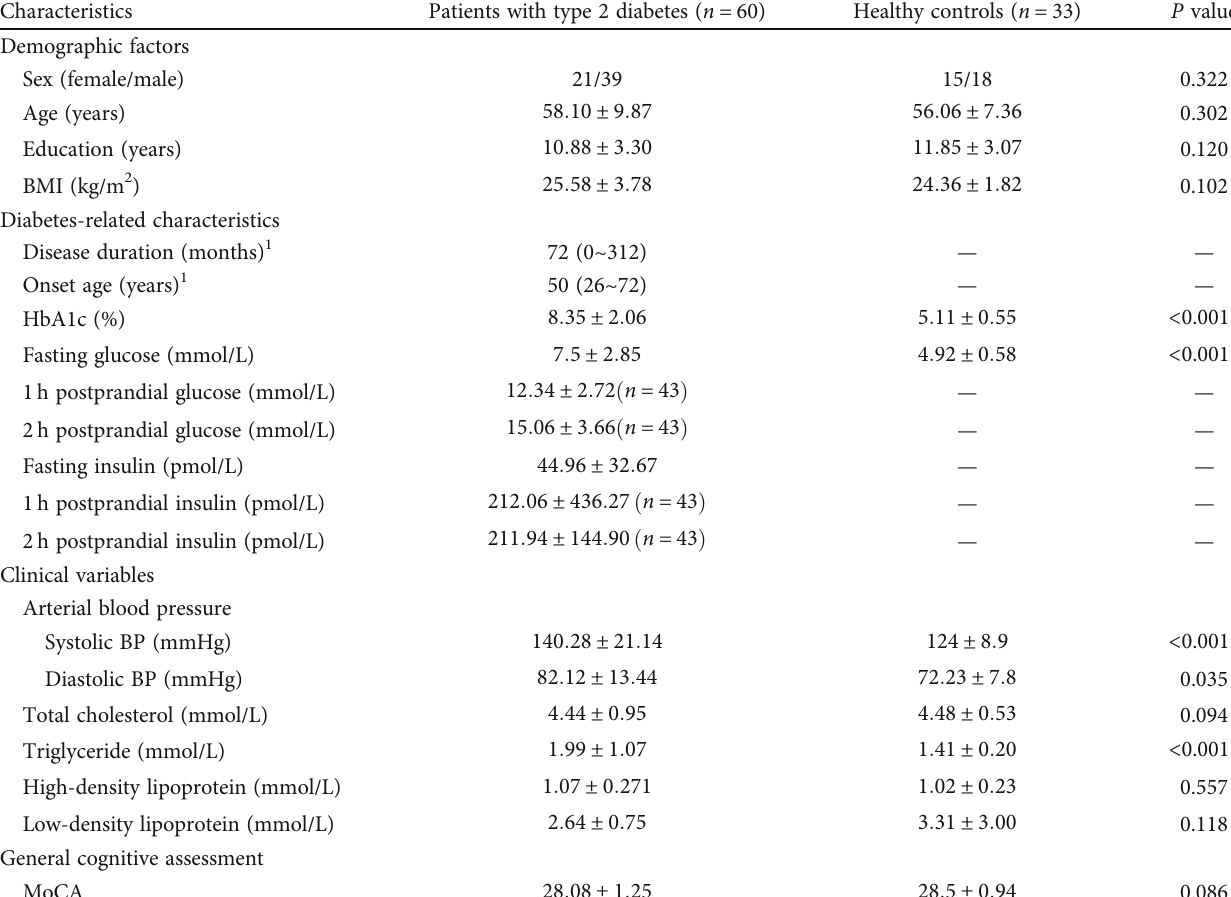
Table 1: Demographic and clinical characteristics of the